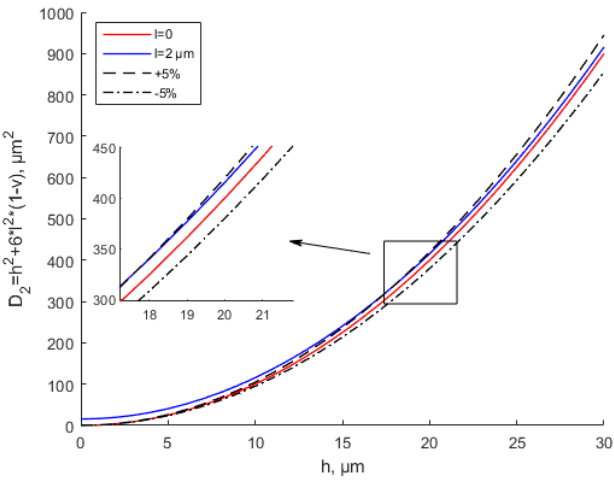
Figure 5. Modified couple stress and classical equivalent bending stiffness of thin plates shown with a small error when l = 2 μ m.